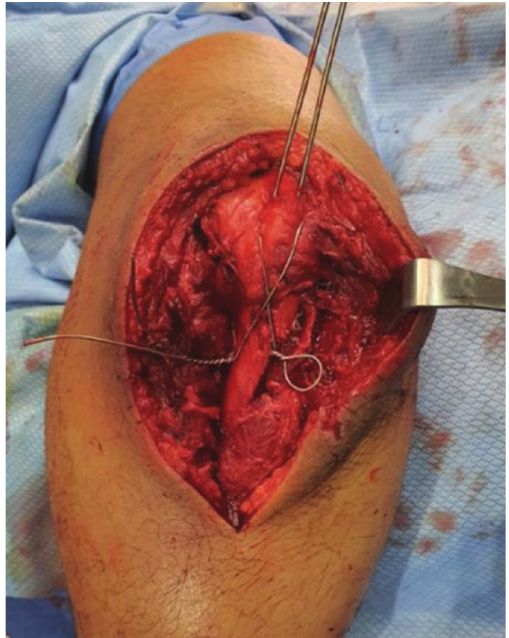
Intra-operative image prior to bending and cutting of wires showing fixation with manageable Fig. 2: